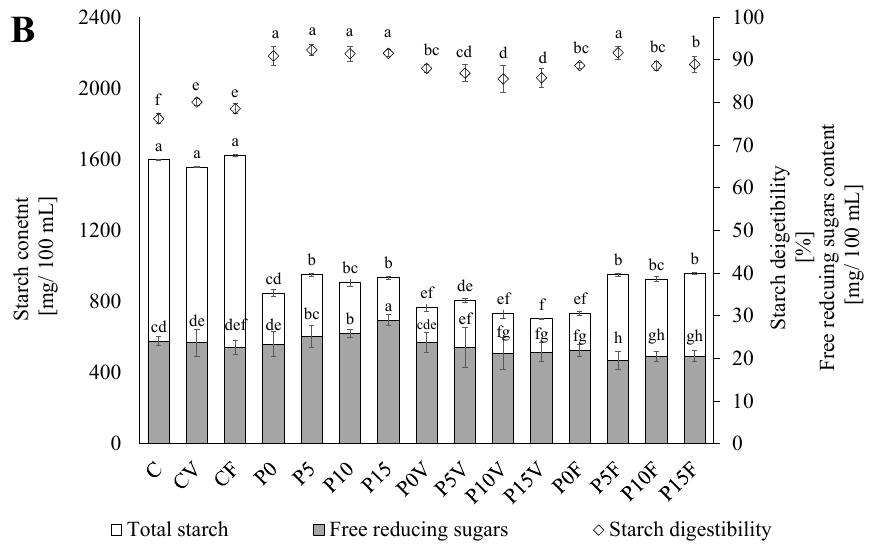
Figure 2. Protein ( A ) and starch ( B ) content and digestibility. C—beverages based on lentil sprouts; P—beverages based on lentil proteins; V—beverages enriched with the lyophilized parsley and broccoli sprouts; F—beverages enriched with the lyophilized strawberry and raspberry; 0–15—percent of flaxseeds gum added. Means in the columns ( ± SD) followed by different letters are significantly different ( n = 9; p ≤ 0.05).